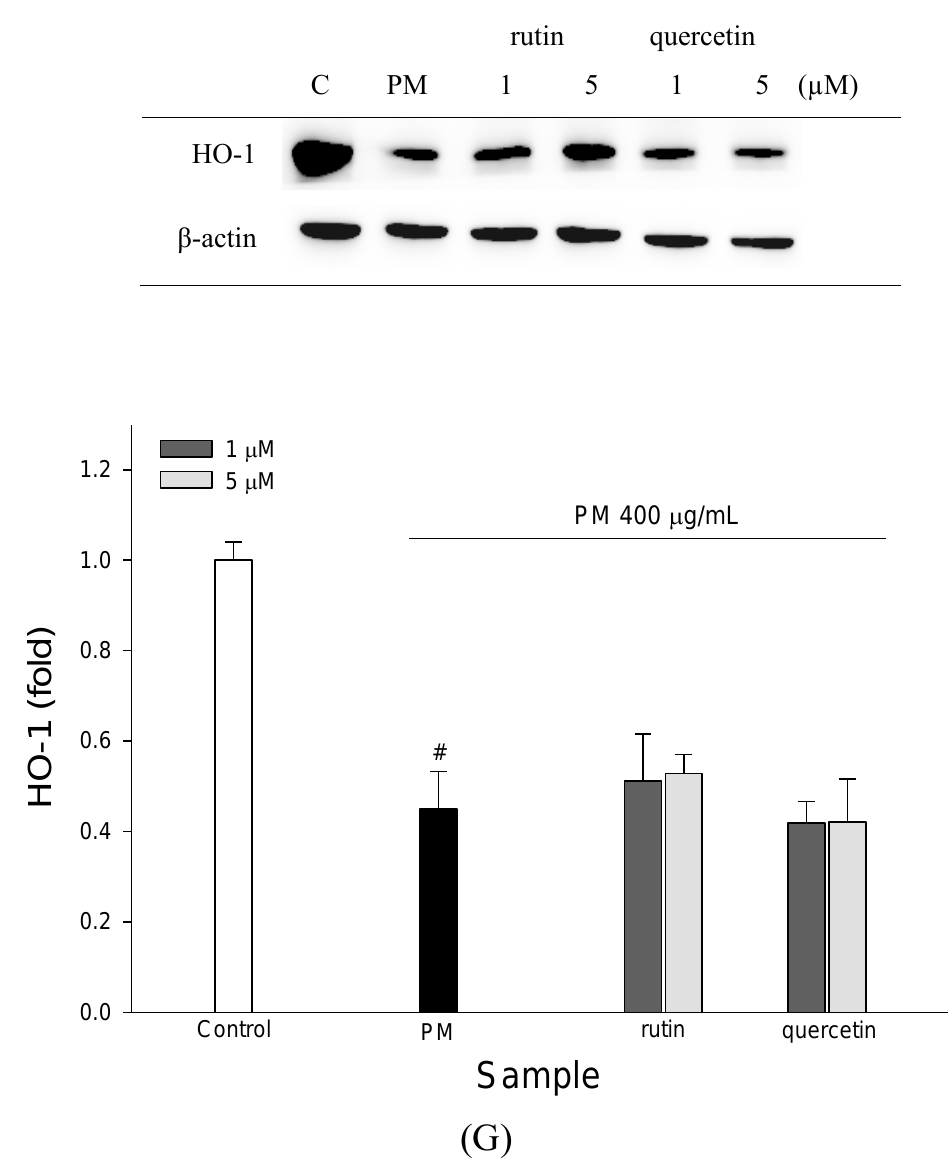
Figure 5. Effects of rutin and quercetin on PM-induced A549 cell viability, oxidation, and antioxidant indices in A549 cells. ( A ) Effects of rutin and quercetin on PM-induced A549 cell viability. The cells were treated with rutin and quercetin, respectively, and exposed to 400 µ g/mL PM for 24 h. ( B ) Effects of rutin and quercetin on PM-induced intercellular ROS production in A549 cells. The cells were treated with rutin and quercetin, respectively, and exposed to 400 µ g/mL PM for 2 h. ( C ). Effects of rutin and quercetin on PM-induced intercellular TBARS formation in A549 cells. The cells were treated with rutin and quercetin, respectively, and exposed to 400 µ g/mL PM for 2 h. ( D ) Effects of rutin and quercetin on PM-induced GSH contents in A549 cells. The cells were treated with rutin and quercetin, respectively, and exposed to 400 µ g/mL PM for 20 h. ( E ) Effects of rutin and quercetin on PM-induced SOD activity in A549 cells. The cells were treated with rutin and quercetin, respectively, and exposed to 400 µ g/mL PM for 24 h. ( F ) Effects of rutin and quercetin on PM-induced expression of Nrf2 in A549 cells. The cells were treated with rutin and quercetin, respectively, and exposed to 400 µ g/mL PM for 12 h. ( G ) Effects of rutin and quercetin on PM-induced HO-1 activity in A549 cells. The cells were treated with rutin and quercetin, respectively, and exposed to 400 µ g/mL PM for 15 h. # ( p < 0.05) compared with the control group and * ( p < 0.05) compared with 400 µ g/mL PM-induced cells alone. Data are presented as means ± SD ( n =